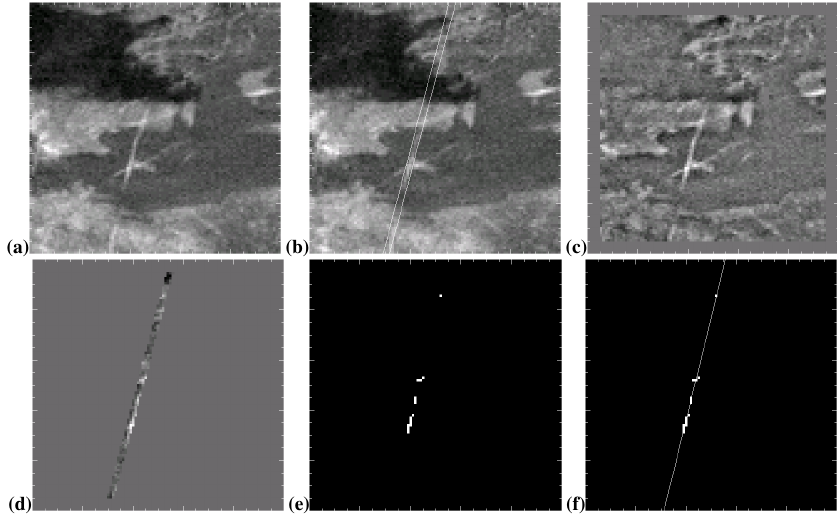
Fig. 06. Test 3. (a) Scene at time t with contrail C ( t ) in the centre of the image. (b) Same scene at time t 0 = t + ∆ t , contrail C ( t 0 ) in the centre of the image between the white lines that delimit the area where C can lie after being drifted by the wind. (c) Enhanced BTD image. (d) Selected wind field related region over the enhanced image. (e) Guide points. (f) Linear fit.